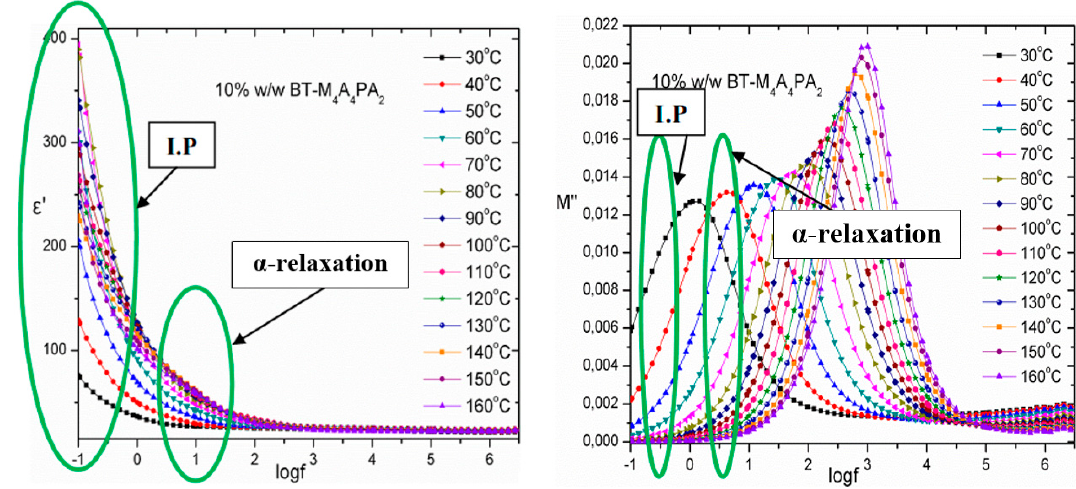
Figure 10. The real part of the dielectric permittivity ( left ) and the imaginary part of the electric modulus ( right ), versus frequency, for the 10% w/w BaTiO 3 -M 4 A 4 PA 2 nano-composites.